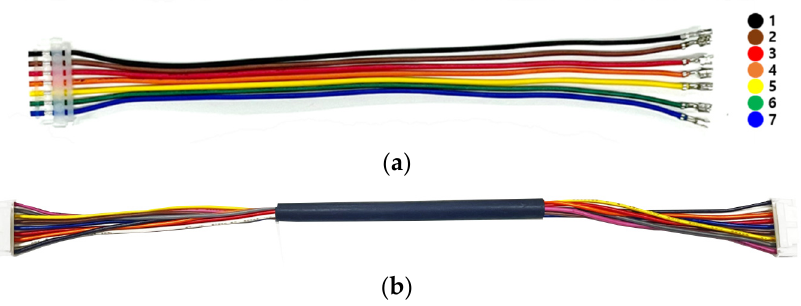
Figure 8. Photograph of real harness. ( a ) Flat harness with 7 wires. ( b ) Circular harness with 9 wires.